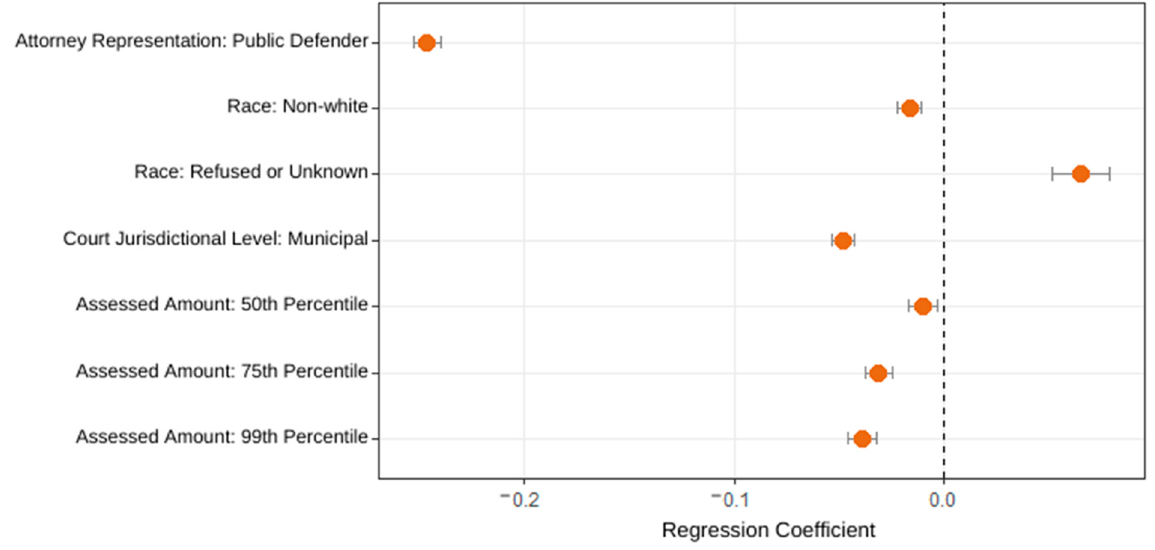
Figure 3. Regression coefficients for the various predictors of a higher rate of LFO payment.